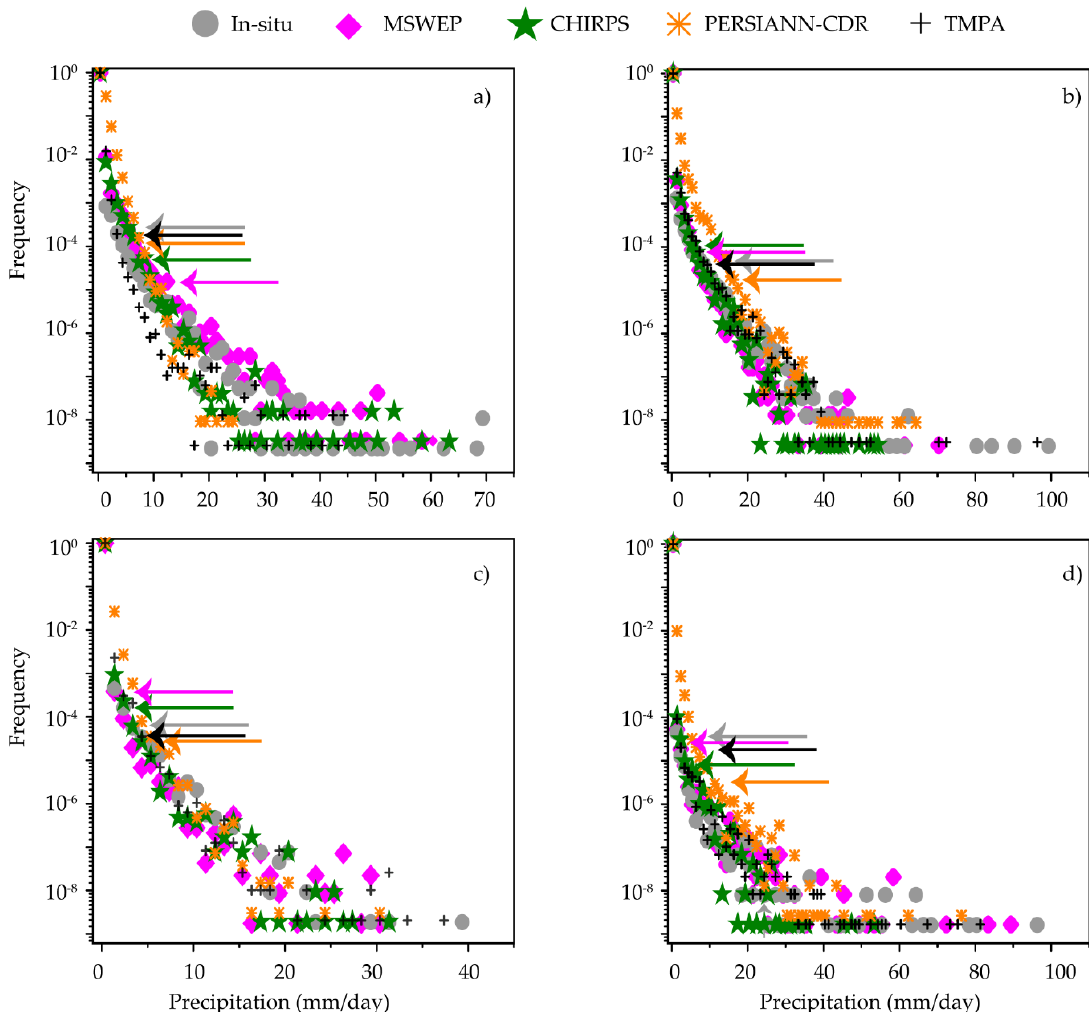
Figure 4. Normalized frequency of daily precipitation in different climatic zones for in-situ and GPPs. The arrows mark the 95th percentile, the bin size used is 1.85 mm/day. ( a ), ( b ), ( c ) and ( d ) are equivalent to regions 1, 2, 3 and 4 in Table 1.